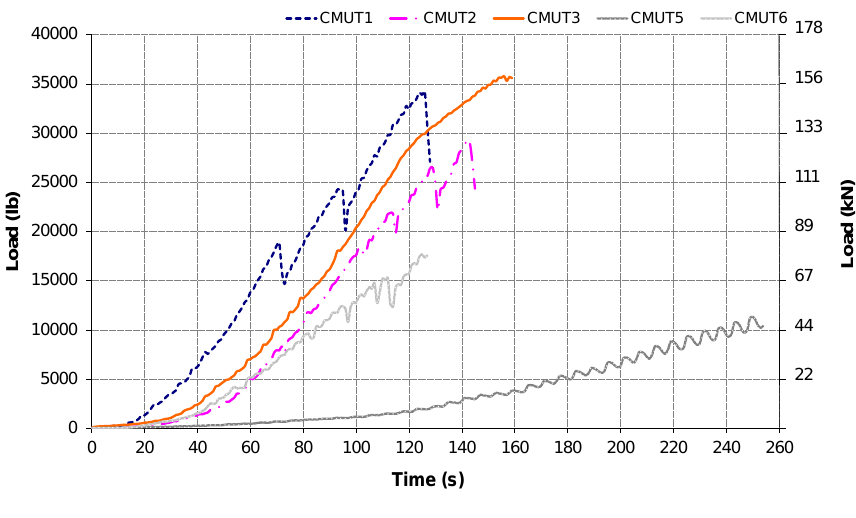
Figure 23. Concrete masonry unit test (CMUT) third story load histories.